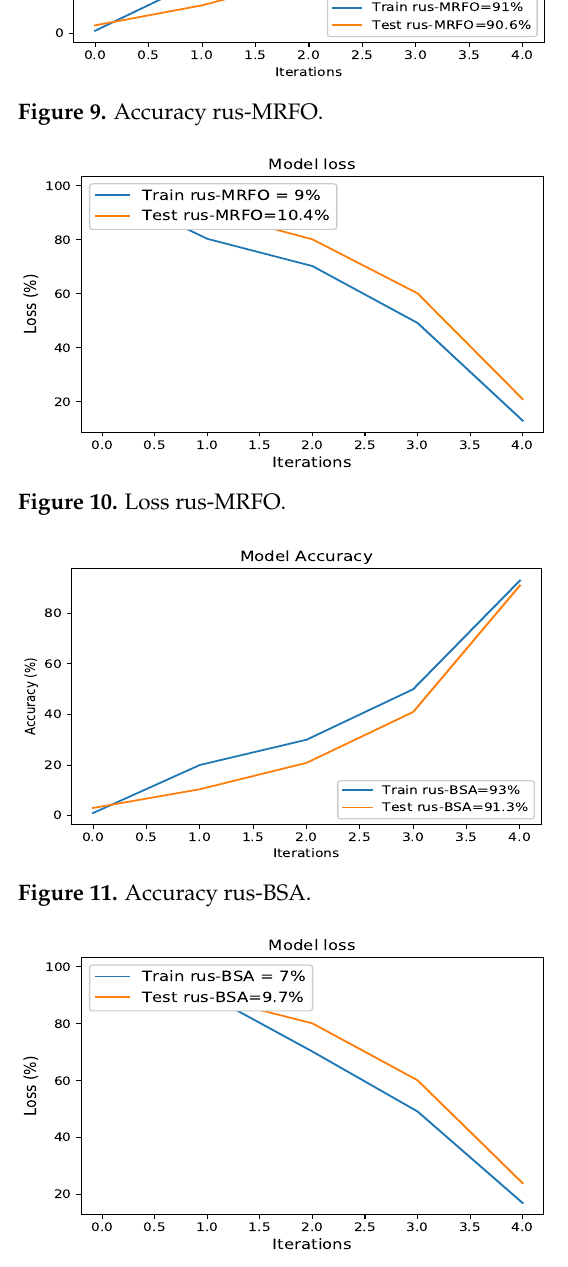
Figure 12. Loss rus-BSA. Figure 13 depicted the overall performance error of different techniques and proposed model is calculated using different measures, such as Mean Absolute Percentage Error (MAPE), Root Mean Square Error (RMSE), and Mean Squared Error(MSE). The performance error of our proposed models rus-MRFO and rus-BSA in terms of MAPE, RMSE, and MSE is 10%, 14.24%, 31.87% and 7%, 10%, 21.5%k,